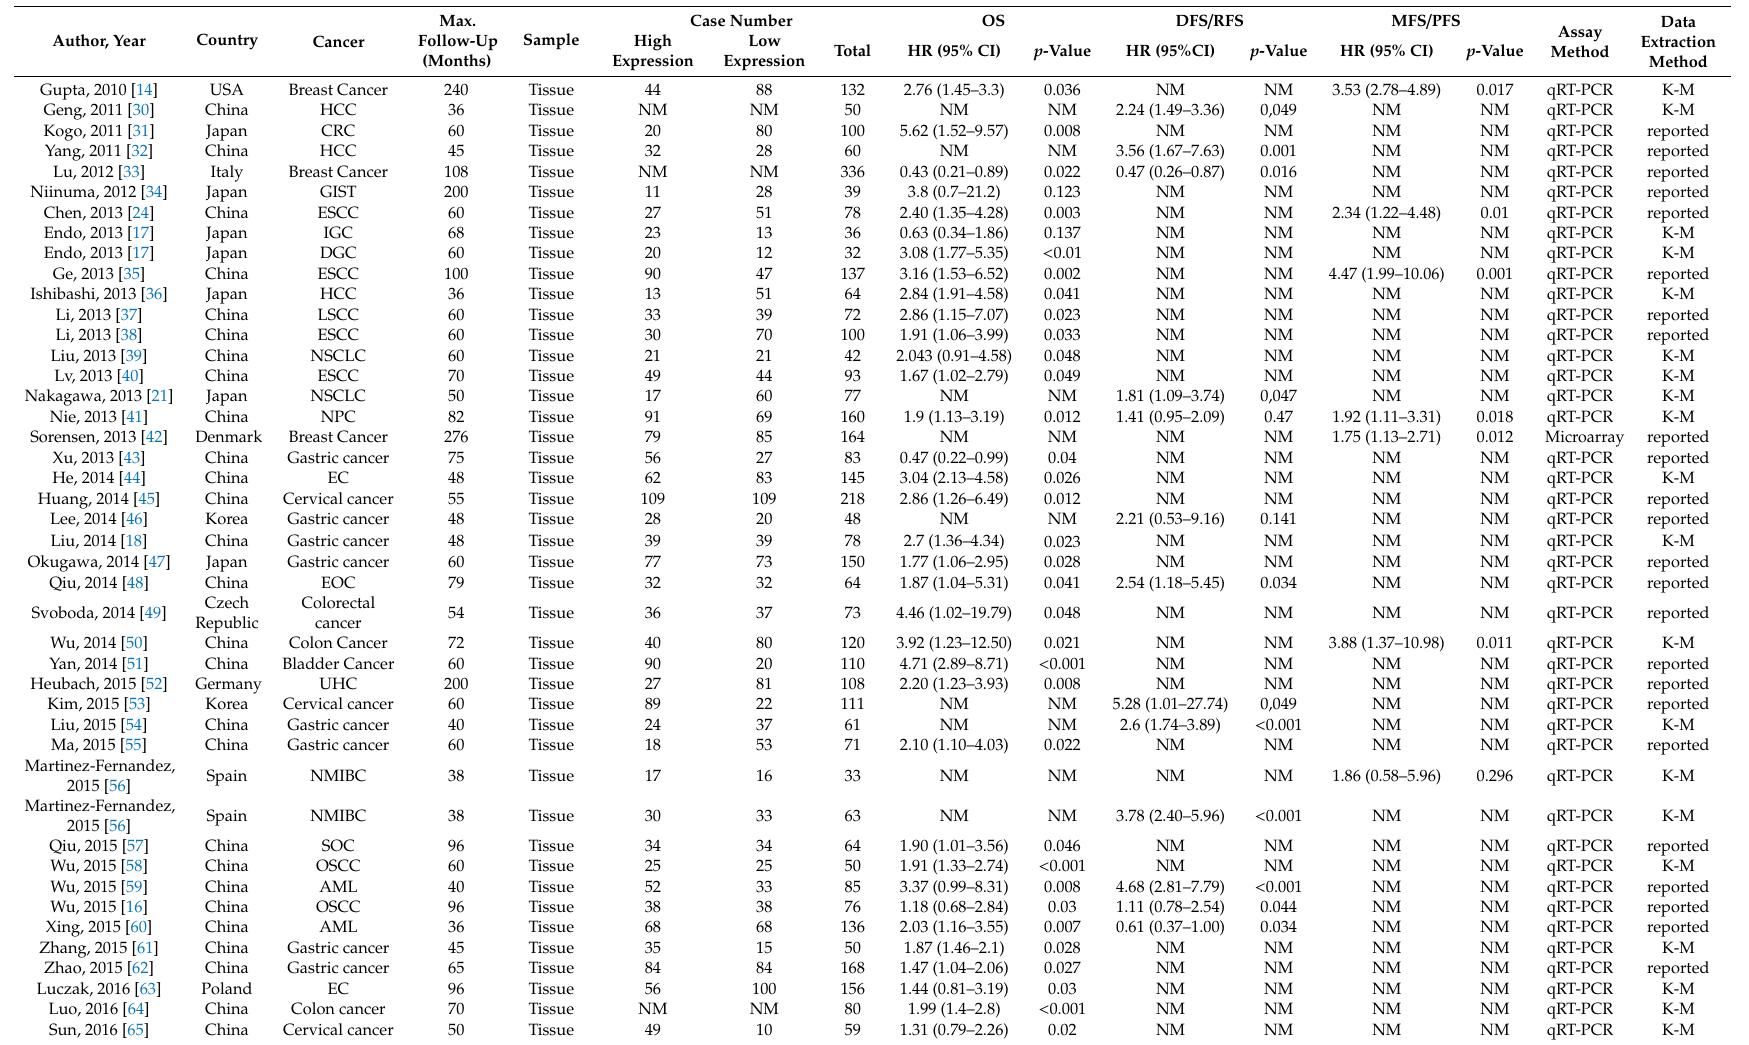
Table 1. Main characteristics of the studies included in the